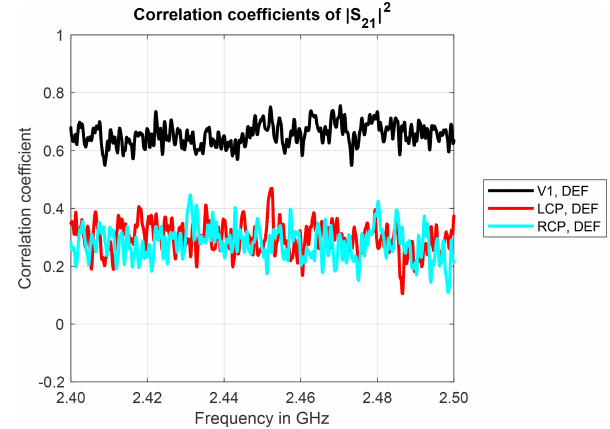
Figure 13. Power correlation coefficients for different antennas and measurement trial 4.